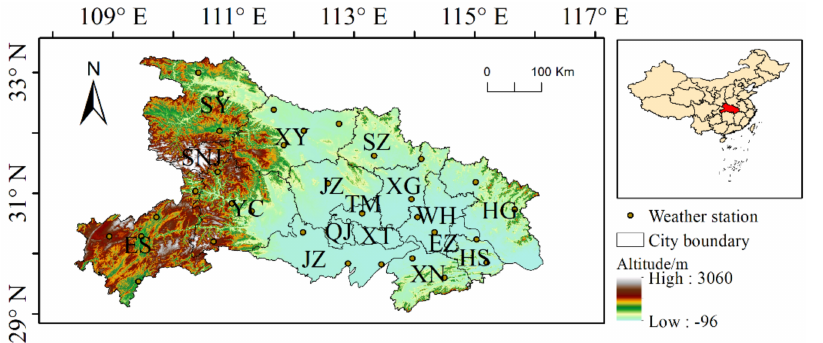
Figure 2. Location and altitude of Hubei